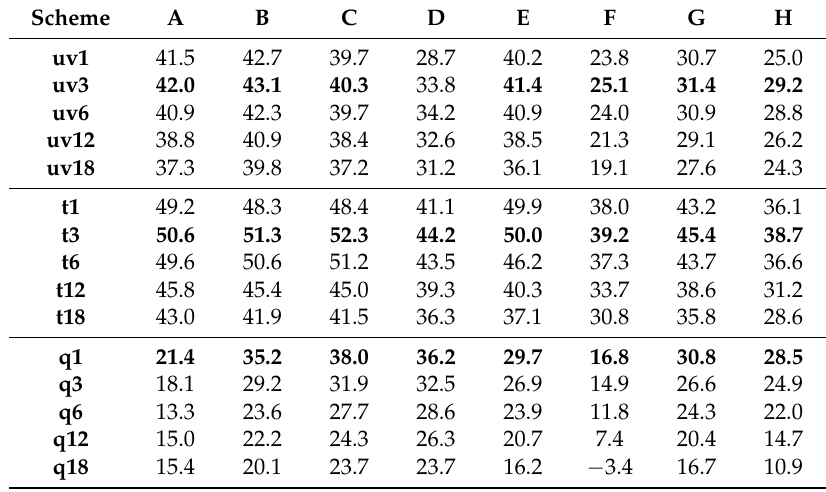
Figure 7. The variation of the CC between the simulated and observed geopotential height at 500 hPa in sub-regions A–H when various nudging times were adopted (the dashed line indicates the CC threshold passing significance t test at 0.1% significance level): ( a ) nudging uv; ( b ) nudging θ ; and ( c ) nudging q. Table 3. Same as Table 2, but for simulations at sounding standard layers.